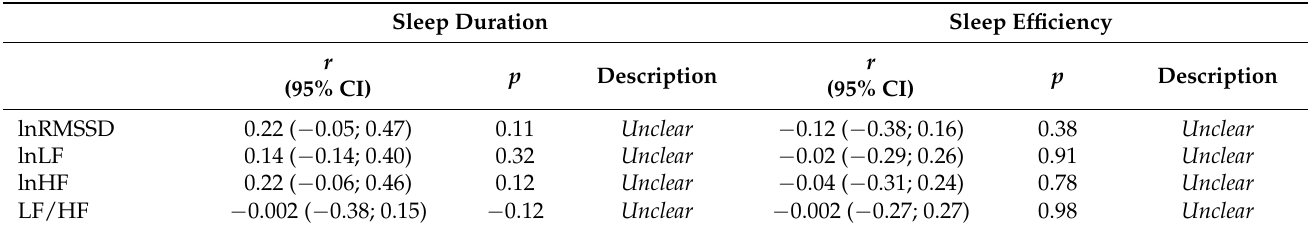
Table 2. Within-subject correlation between players’ sleep indices and nocturnal cardiac autonomic activity during the 5-days tournament (n = 18).